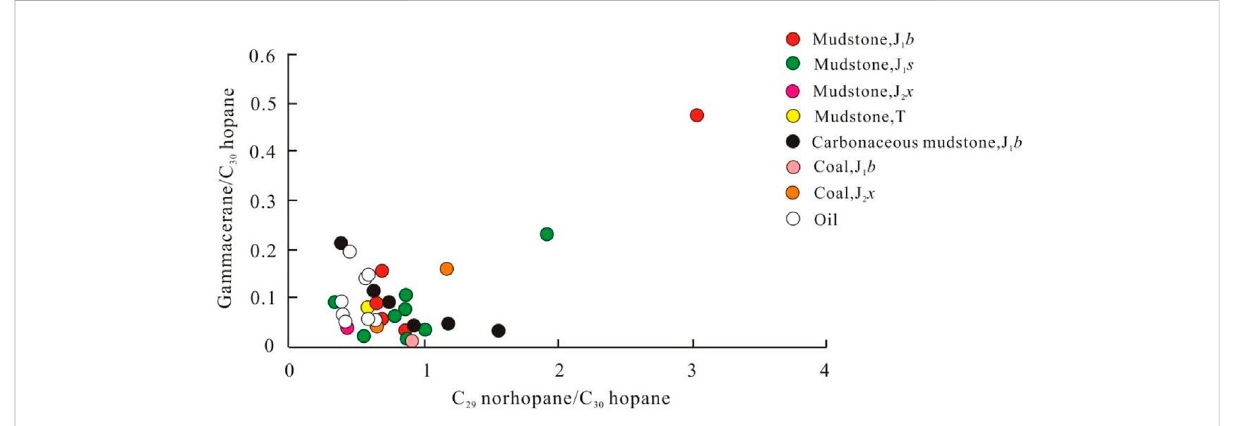
FIGURE 12 Relationship between gammacerane/C 30 hopane and C 29 norhopane/C 30 hopane in Middle and Lower Jurassic crude oil and source rocks in the study